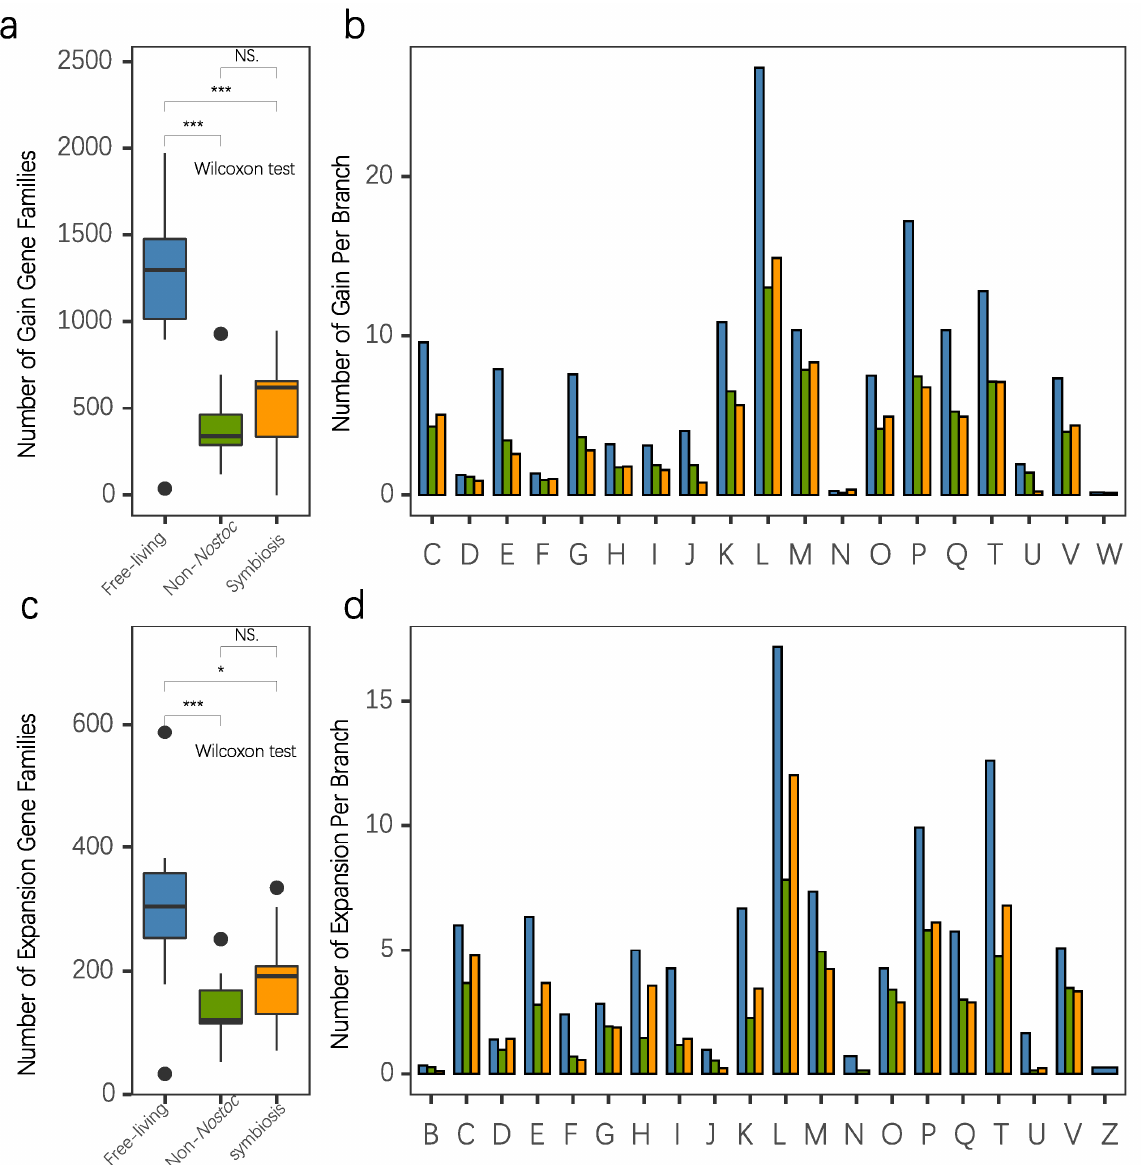
Figure 6. Evolutionary events related to genome enlargement in the exterior branch. Average gene family of ( a ) gain and ( b ) expansion (increasing paralog). ( c , d ). Gene family gained per branch among free-living Nostoc (FL), symbiotic Nostoc (SN), and non- Nostoc species (NN). Asterisks indicate significant differences based on Wilcoxon test (* p < 0.05 *** p < 0.001).